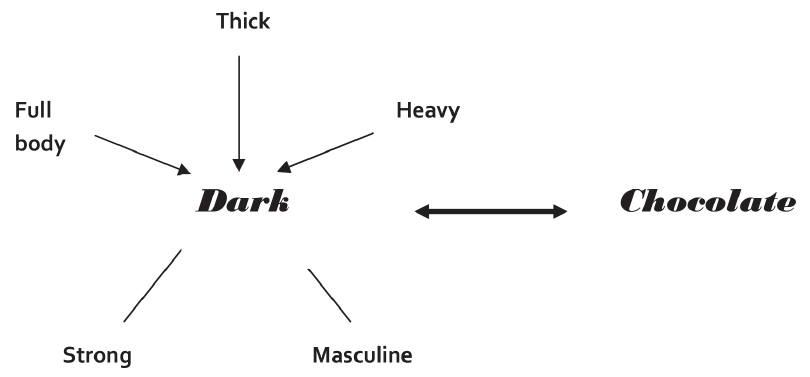
<Figure 5> The Conceptualization of Wine Regional Advertising Campaign For Barossa Valley Shiraz ‘Dark Chocolate, the Taste of Barossa